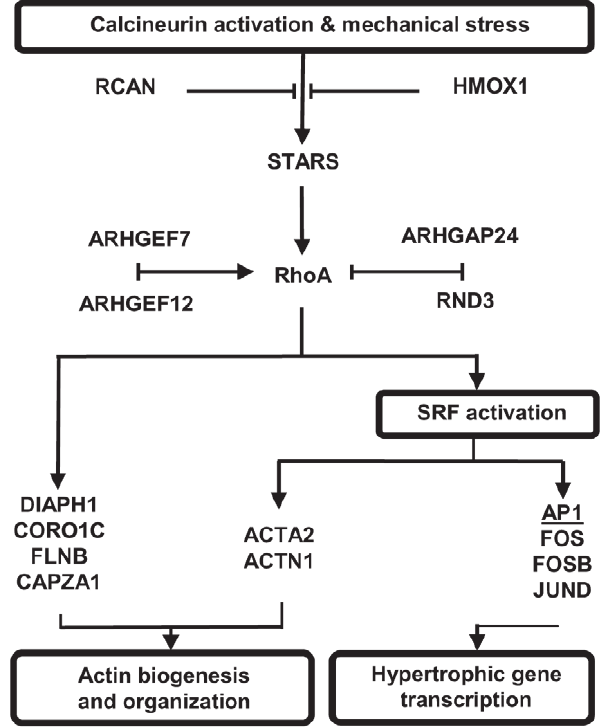
Figure 5. Schematic representation of the transcriptionally active pathways following exercise induced muscle damage. Eccentric exercise promoted greater expression of targets within the STARS/RhoA/AP1 and NFAT/AP1 signaling pathways for hypertrophy and actin biogenesis and organization.